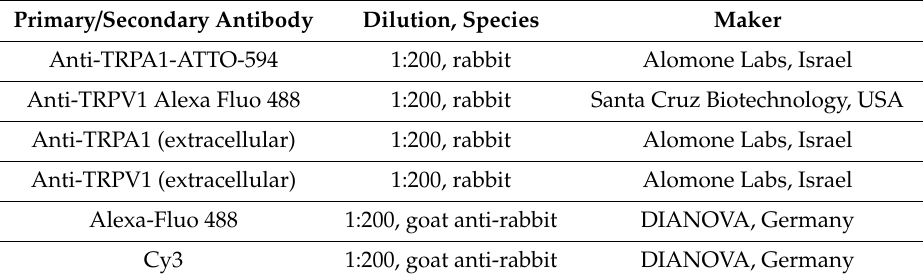
Table 1. Antibodies and dilution used for the TRPA1- and TRPV1-positive staining. Primary / Secondary Antibody Dilution, Species Maker Anti-TRPA1-ATTO-594 1:200, rabbit Alomone Labs, Israel Anti-TRPV1 Alexa Fluo 488 1:200, rabbit Santa Cruz Biotechnology, USA Anti-TRPA1 (extracellular) 1:200, rabbit Alomone Labs, Israel Anti-TRPV1 (extracellular) 1:200, rabbit Alomone Labs, Israel Alexa-Fluo 488 1:200, goat anti-rabbit DIANOVA, Germany Cy3 1:200, goat anti-rabbit DIANOVA,